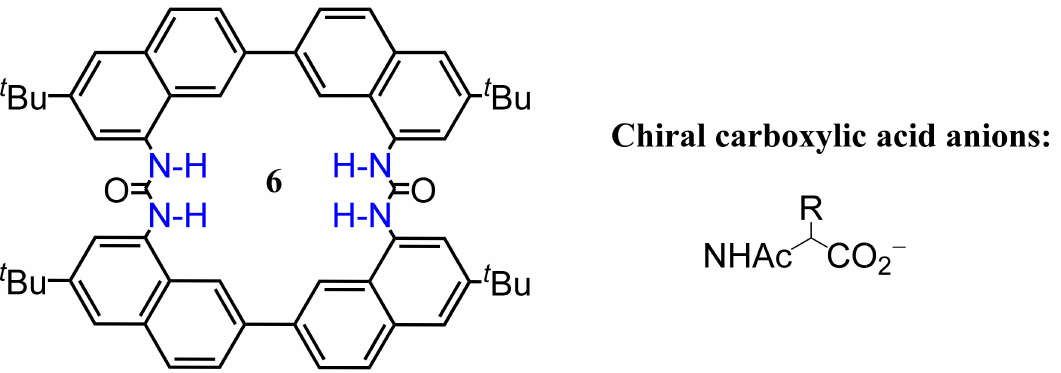
Figure 4. Chemical structure of the chiral guest and naphthalene macrocycle 6